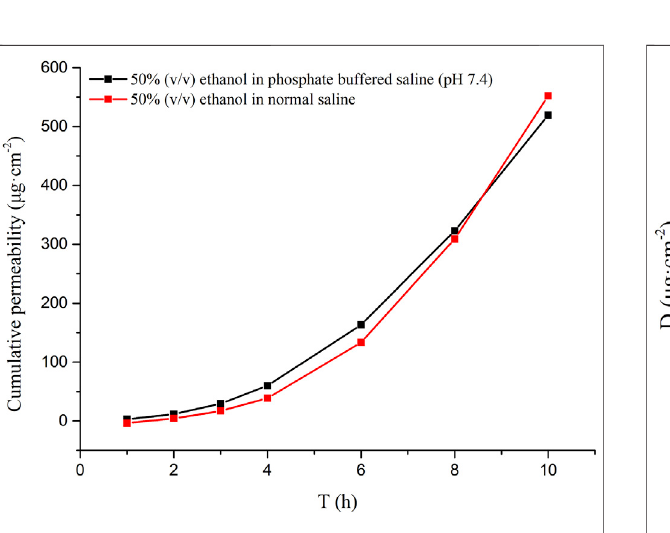
FIGURE 9 | Cumulative penetration rate-time curve of LFs microemulsion.